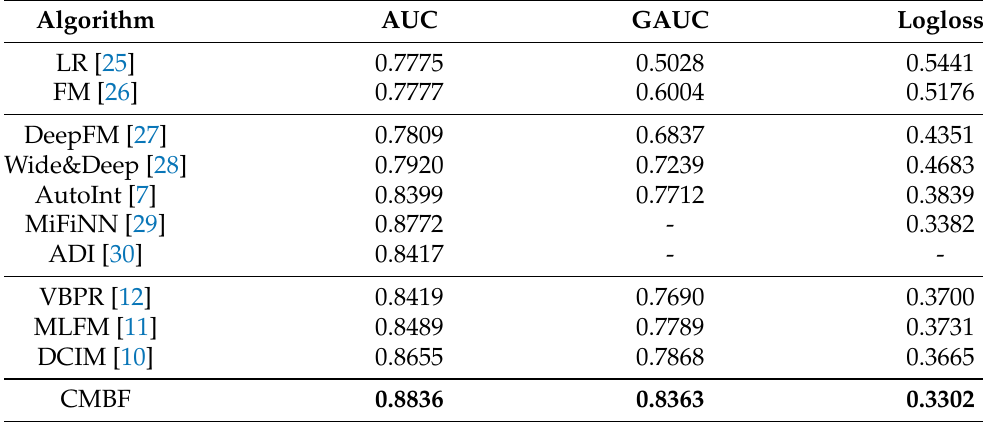
Table 4. Comparison of different algorithms on the MovieLens dataset. The results in bold represent the best performances.